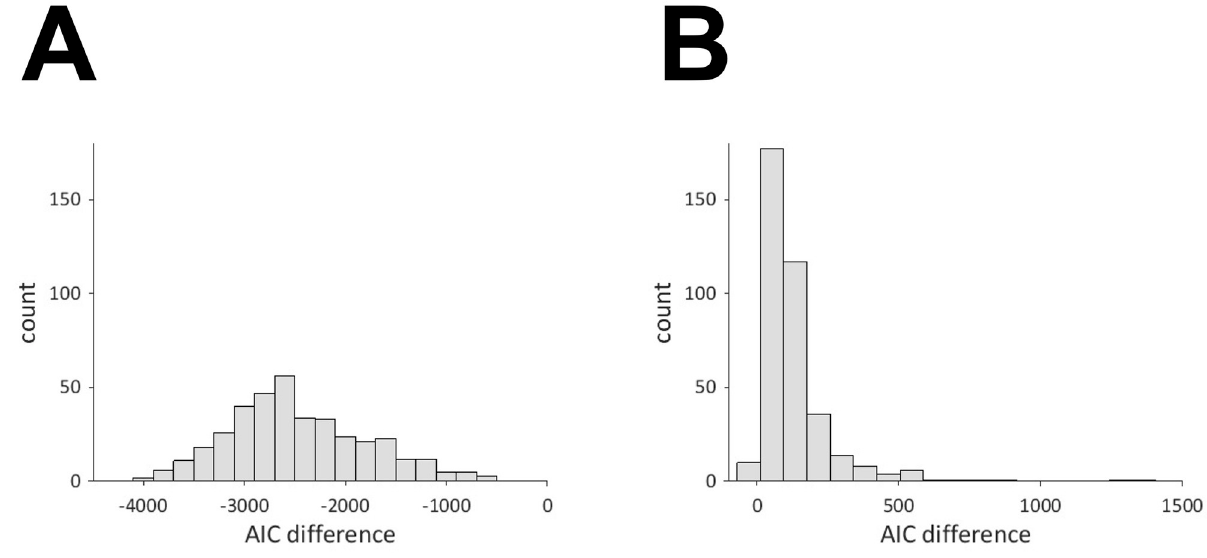
Fig 15. Histogram of AIC difference for (A) same channel and (B) different channels.